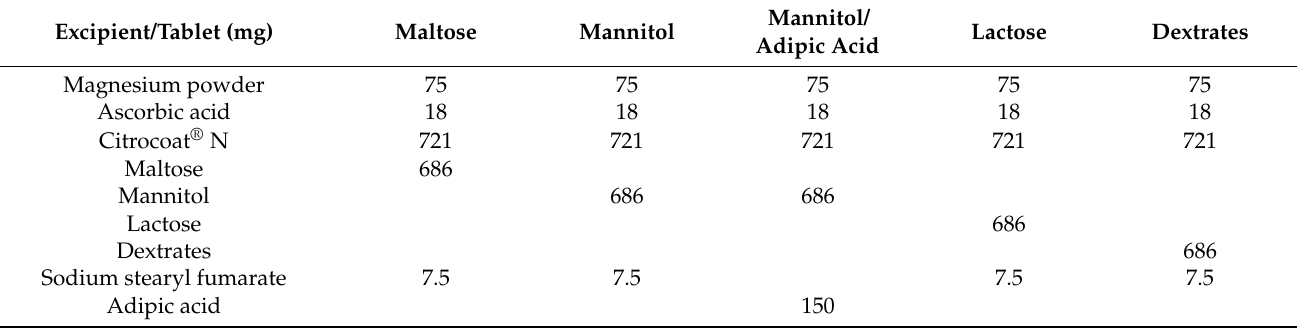
Table 7. Stochiometric quantity of each excipient included in one tablet of the respective batches. Excipient/Tablet (mg) Maltose Mannitol Magnesium